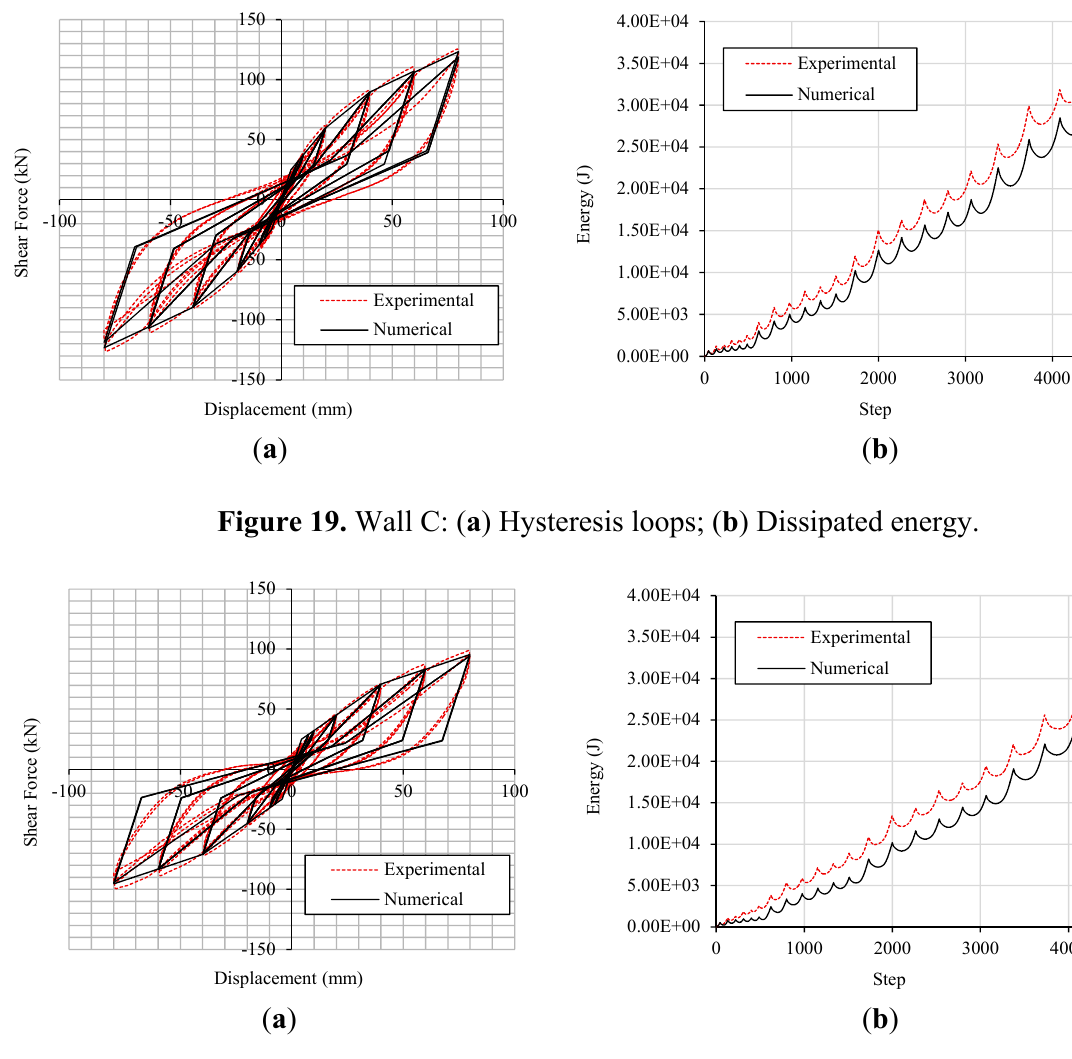
Figure 18. Wall B: ( a ) Hysteresis loops; ( b ) Dissipated energy.